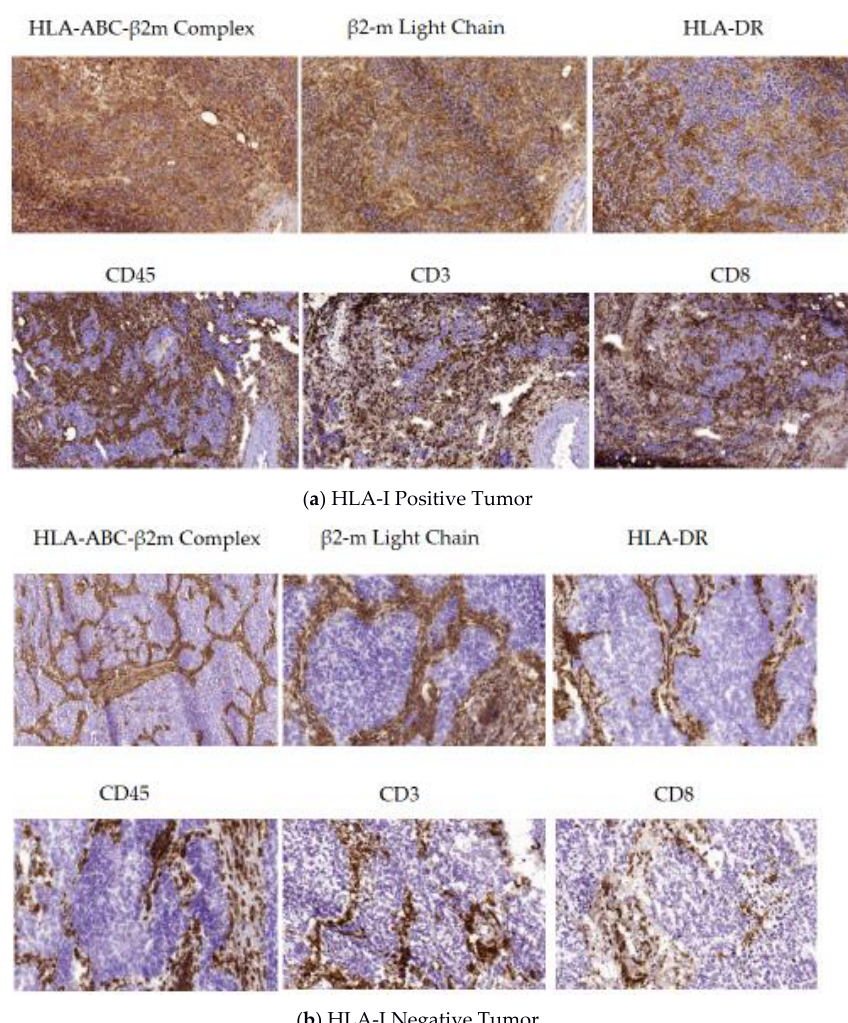
Figure 2. ( a ) Tissue architecture in HLA-I positive tumors (Phase I). Tumor tissue samples obtained from a patient diagnosed with non-small cell lung cancer (NSCLC) were immunostained with monoclonal antibodies against HLA-I, β2-microglobulin, HLA class II, CD8, CD3, and CD45 molecules. Most of the cancer cells are HLA-I positive and remain in close contact with HLA-I positive immune cells. The tissue structure is “permissive”, allowing TILs to enter the tumor mass, producing a significant CD8+ infiltration, and permitting a direct contact with cancer cells. Tumor parenchyma and stroma cannot be distinguished when immunostained for HLA-I expression. This tissue organization pattern in HLA-I positive tumors differs from that observed in HLA-I negative tumors depicted in Figure 2b; ( b ) Tissue architecture in HLA-I negative tumors (Phase II). In contrast to Figure 2a, this lung cancer tissue, obtained from another patient, is negative for both HLA-I and -II. T cells and other leukocytes are restricted exclusively to the peritumoral stroma that surrounds the tumor nest in a “non-permissive” tissue structure. There is a clear separation between tumor parenchyma and surrounding stroma. Tumor nodes are composed exclusively of HLA-I negative tumor cells without any infiltrating immune cells (phase of “immunological